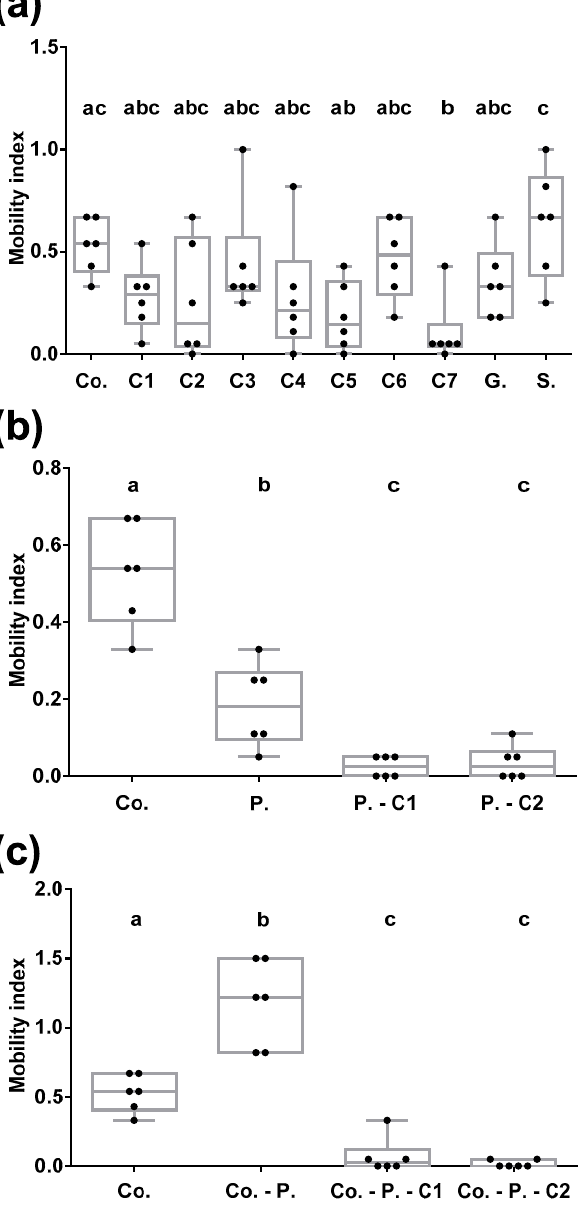
Figure 4. Evaluation of the mobility of C. sordidus (BW) subjected to di ff erent olfactory stimuli. ( a ) E ff ect of fungal VOCs and other compounds (technical repellents) versus no stimuli. C7 and C5 are the ones that reduced the most BW mobility. Abbreviations: Co. = Corm, C1 = styrene, C2 = benzothiazole, C3 = camphor, C4 = borneol, C5 = 1,3-dimethoxy-benzene, C6 = 1-octen-3-ol, C7 = 3-cyclohepten-1-one, G = garlic, S = colloidal Sulphur. ( b ) E ff ect of fungal VOCs on C. sordidus pheromone attractiveness. C1 and C2 mask pheromone attractiveness on BW. Co. = Corm vs. no stimuli; P. = Pheromone vs. no stimuli; P.-C1 = Pheromone vs. C1; P.-C2 = Pheromone vs. C2 ( c ) E ff ect of banana corm, BW aggregation pheromone and fungal VOCs attractiveness to C. sordidus . C1 and C2 mask banana corm and pheromone attractiveness on BW. Co. = Corm vs. no stimuli; Co.-P. = Corm vs. Pheromone; Co.-P.-C1 = Corm vs. Pheromone + C1; Co.-P.-C2 = Corm vs. Pheromone + C2. Di ff erent letters indicate significant di ff erences between treatments ( p <